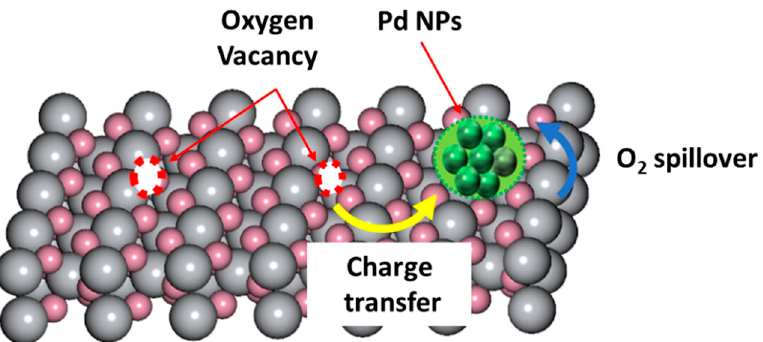
Figure 5. Electron transfer between Pd and reducible metal oxide.